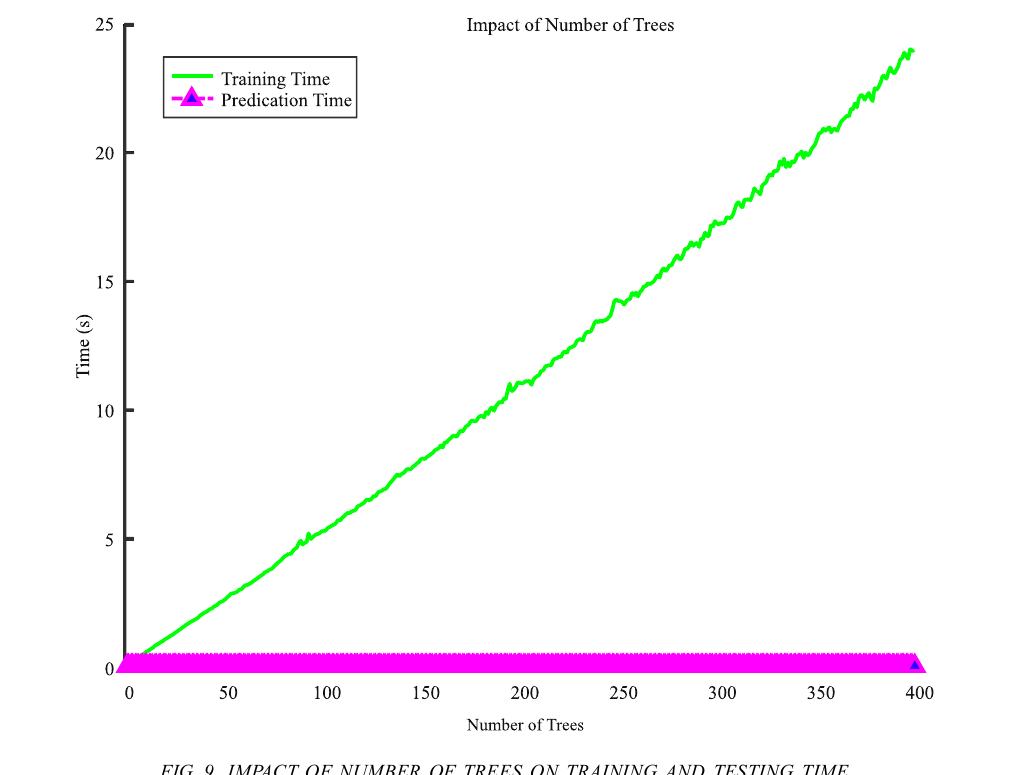
FIG. 9. IMPACT OF NUMBER OF TREES ON TRAINING AND TESTING